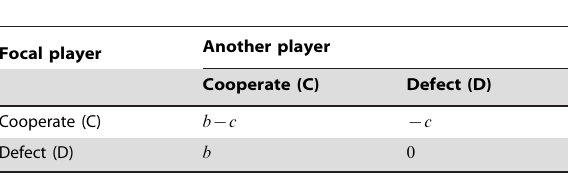
Table 3. The Prisoner’s Dilemma